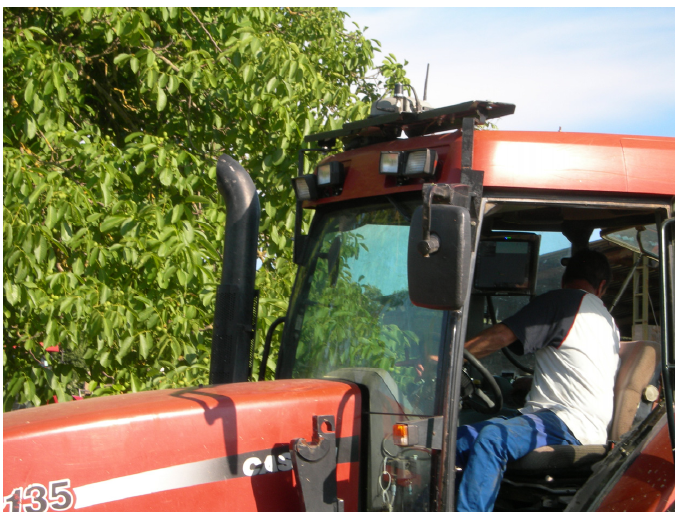
Figure 2. Monitor and antenna installed on the tractor.